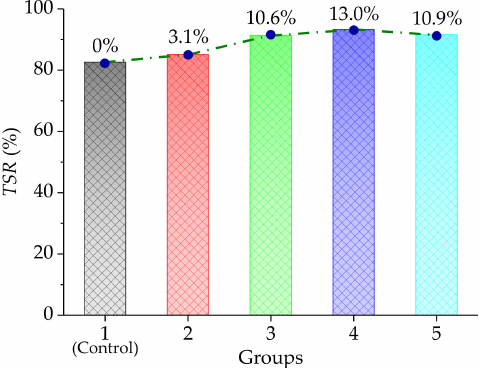
Figure 10. Moisture stability results of the freeze-thaw splitting test.